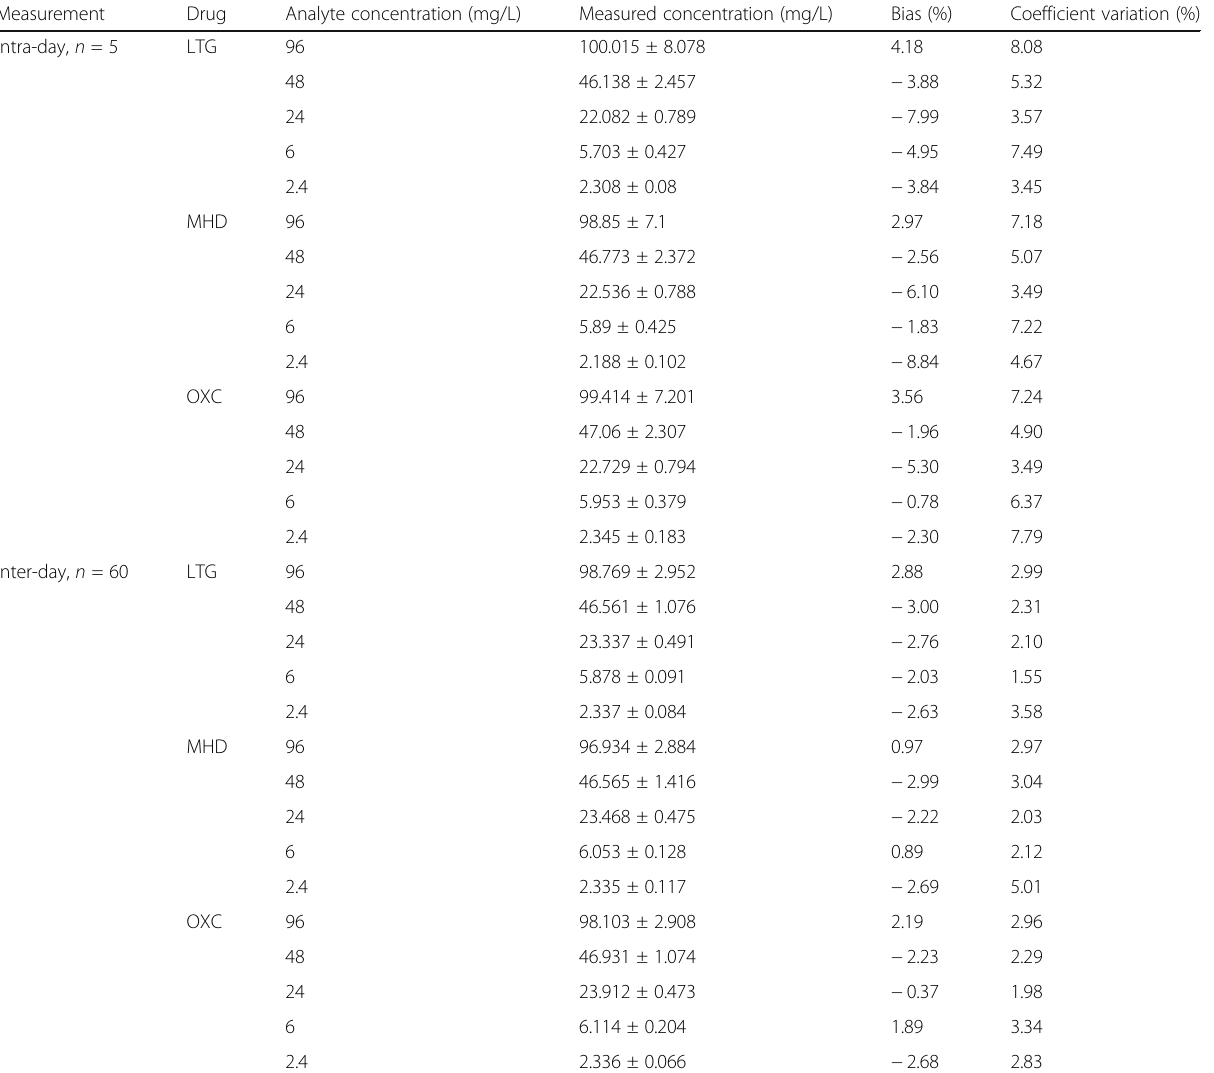
Table 1 The precision and accuracy of LTG, MHD, and OXC in human blood plasma (mean ± standard deviation) Measurement Drug Analyte concentration (mg/L)